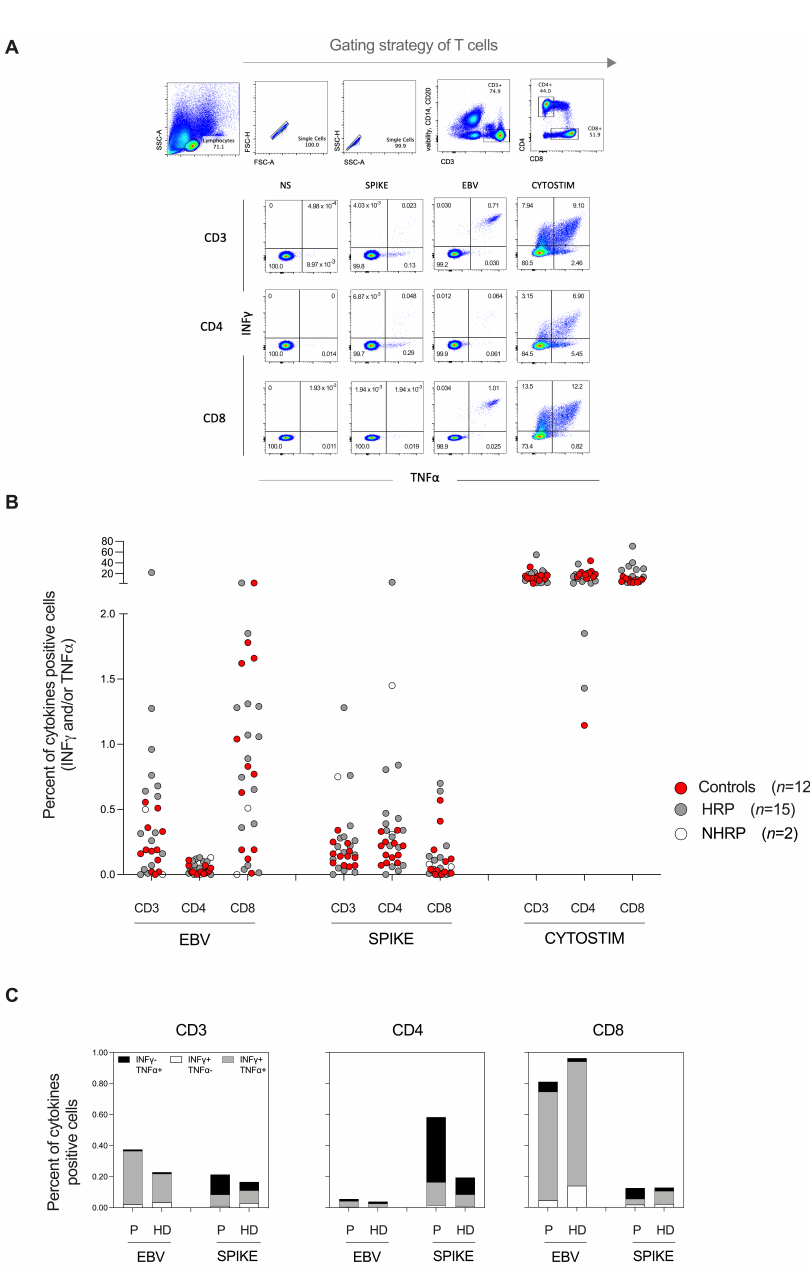
Figure 2. K562 cells were treated with DHA, ( β )- 7c , and vorinostat (0.4 µ M) for 24 h. Subsequently, cell lysates were immunobloted with anti-acetyl- α -tubulin and acetyl-histone H3 antibodies, whereas GAPDH served as a loading control. The experiments were repeated three times ( n = 3), and a representative blot is shown